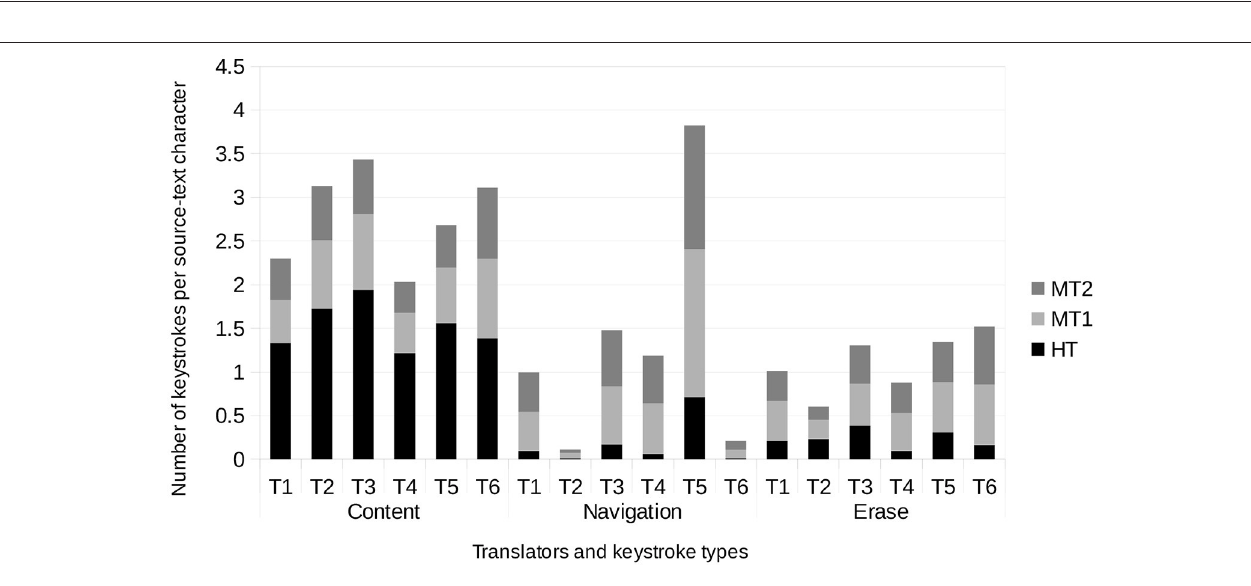
FIGURE 7 | Proportion of each keystroke type (content, navigation and erase) in each translation condition (HT, MT1, and MT2) and for each